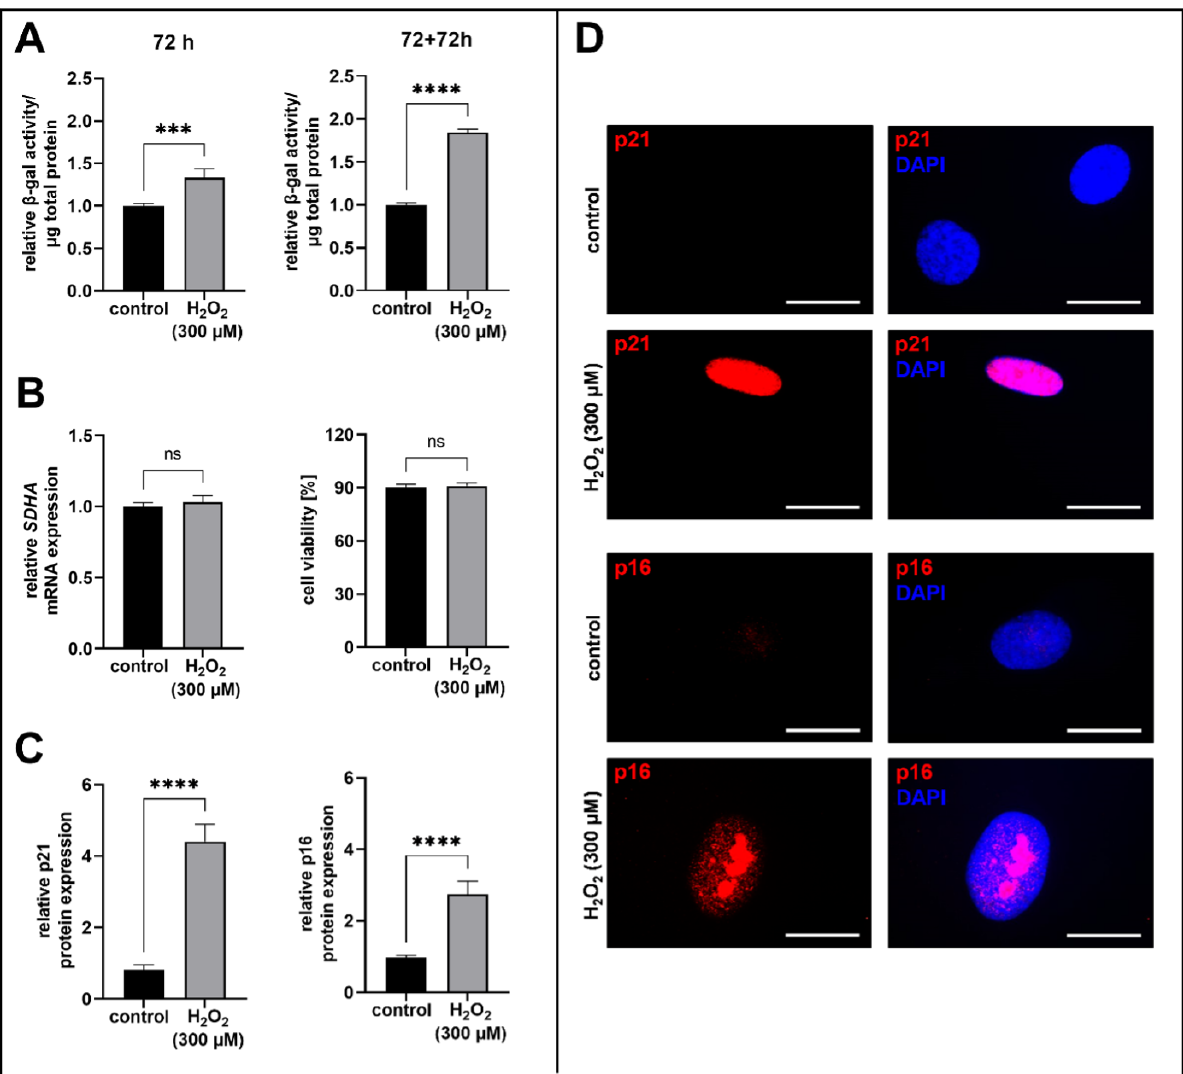
Figure 1. Quantification of H 2 O 2 -induced acute senescence in human proto-myofibroblasts. After a cultivation time of 24 h, cells were treated for 1 h with 300 µ M H 2 O 2 or H 2 O (control). ( A ) Acute senescence of human proto-myofibroblasts was detected by the determination of SA β -galactosidase activity after 72 h or after reseeding and an additional cultivation time of 72 h (72 + 72 h). The spectrophotometrically measurement of the fluorescence intensity of 4-methylumbelliferyl- β -D- galactopyranoside was detected by using the Tecan Reader Infinite 200 PRO (excitation: 360 nm, emission: 465 nm, integration: 40 µ s). The values shown are means ± SEM for three biological and three technical replicates per experiment (n = 3) and were calculated relative to the respective control. ( B ) The cell viability was investigated by measuring the succinate dehydrogenase complex flavoprotein subunit A ( SDHA ) mRNA expression level at 6 h by quantitative real-time PCR